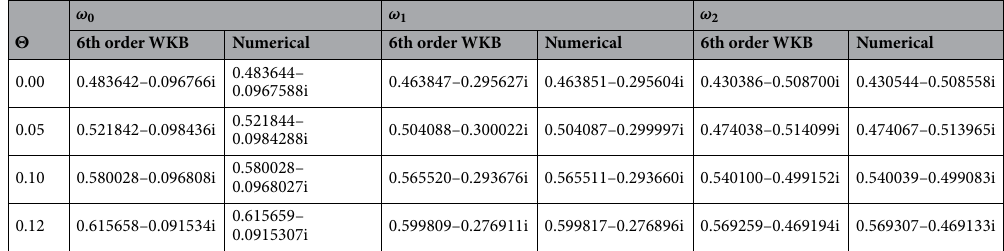
Table 1. QN frequencies for l = 1 .